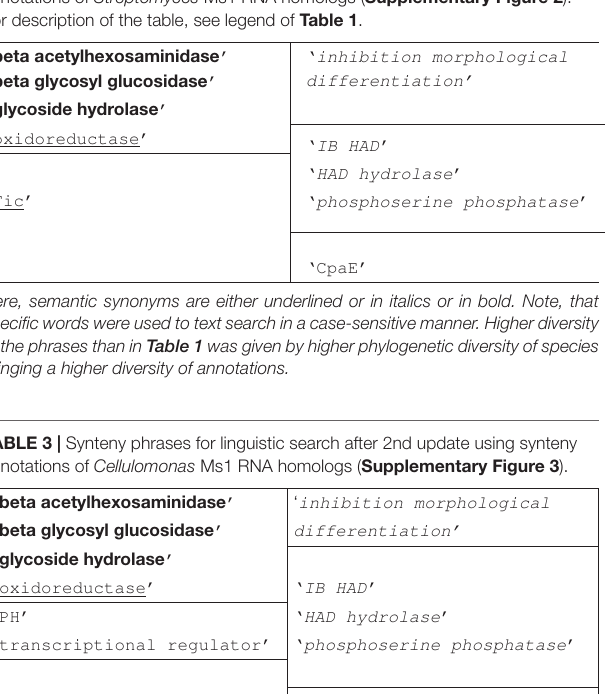
Table 2 and Supplementary Figure 5 for specific words